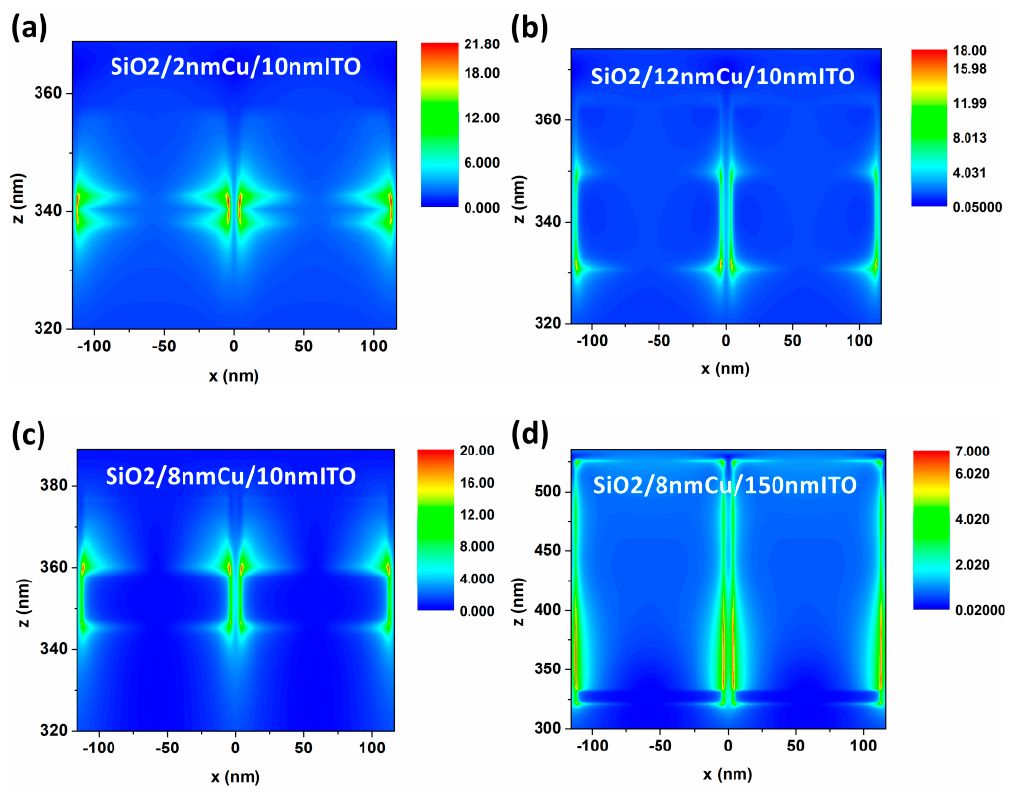
Figure 7. Cross-section electric field distributions of SiO 2 /Cu/ITO microstructures with various wavelengths of incident light: ( a ) 1243 nm; ( b ) 753 nm; ( c ) 1378 nm; ( d ) 1694 nm.